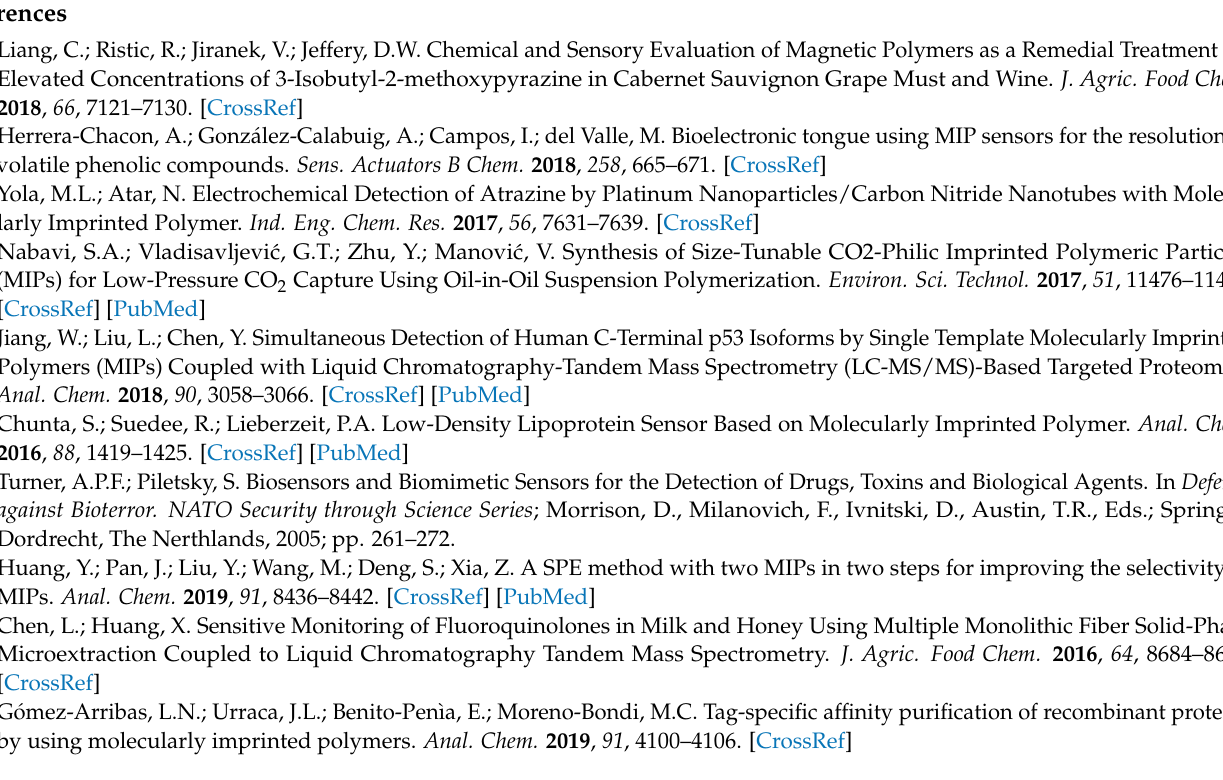
calibration curves. Figure S6: Interferent study at different ratios for TNT versus acetaminophen, serotonin and tryptamine. Figure S7: Schematic representation of different species used into the discrimination study. Figure S8. Differential pulse voltammograms for 10 mol L − 1 of [A] NB,